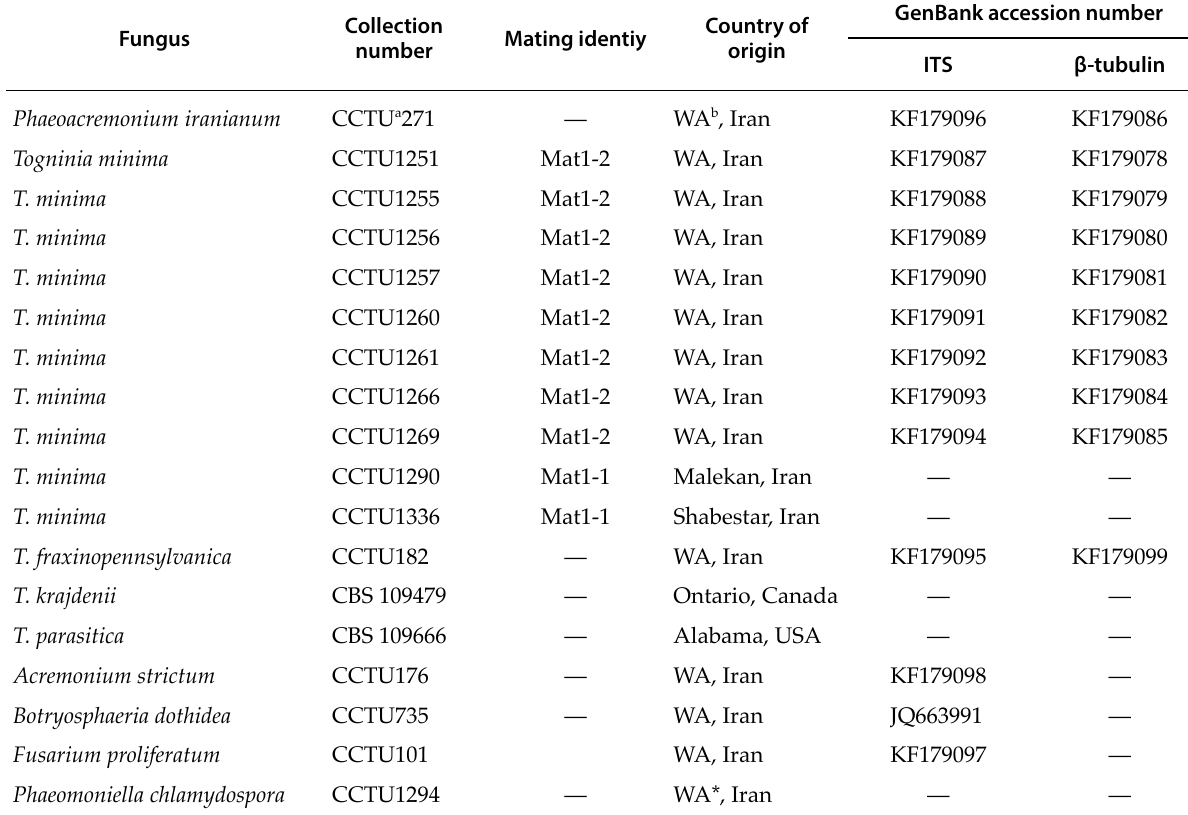
Table 1. Togninia / Phaeoacremonium and other fungal species used to test the specificity of PCR primers.